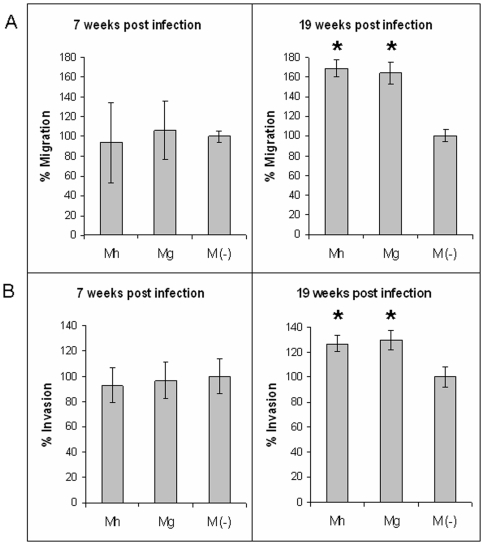

In vitro invasion and migration.BPH-1 cells with and without M. genitalium (Mg) or M. hyorhinis (Mh) infection were tested for migration (A) and invasion (B) potential at weeks 7 and 19 post-infection. Both M. genitalium and M. hyorhinis infected BPH-1 cells had increased migration and invasion rates at week 19. Data presented are means of triplicates, and the error bars represent the standard error of the mean. *, p<0.05 versus no mycoplasma control (M-).